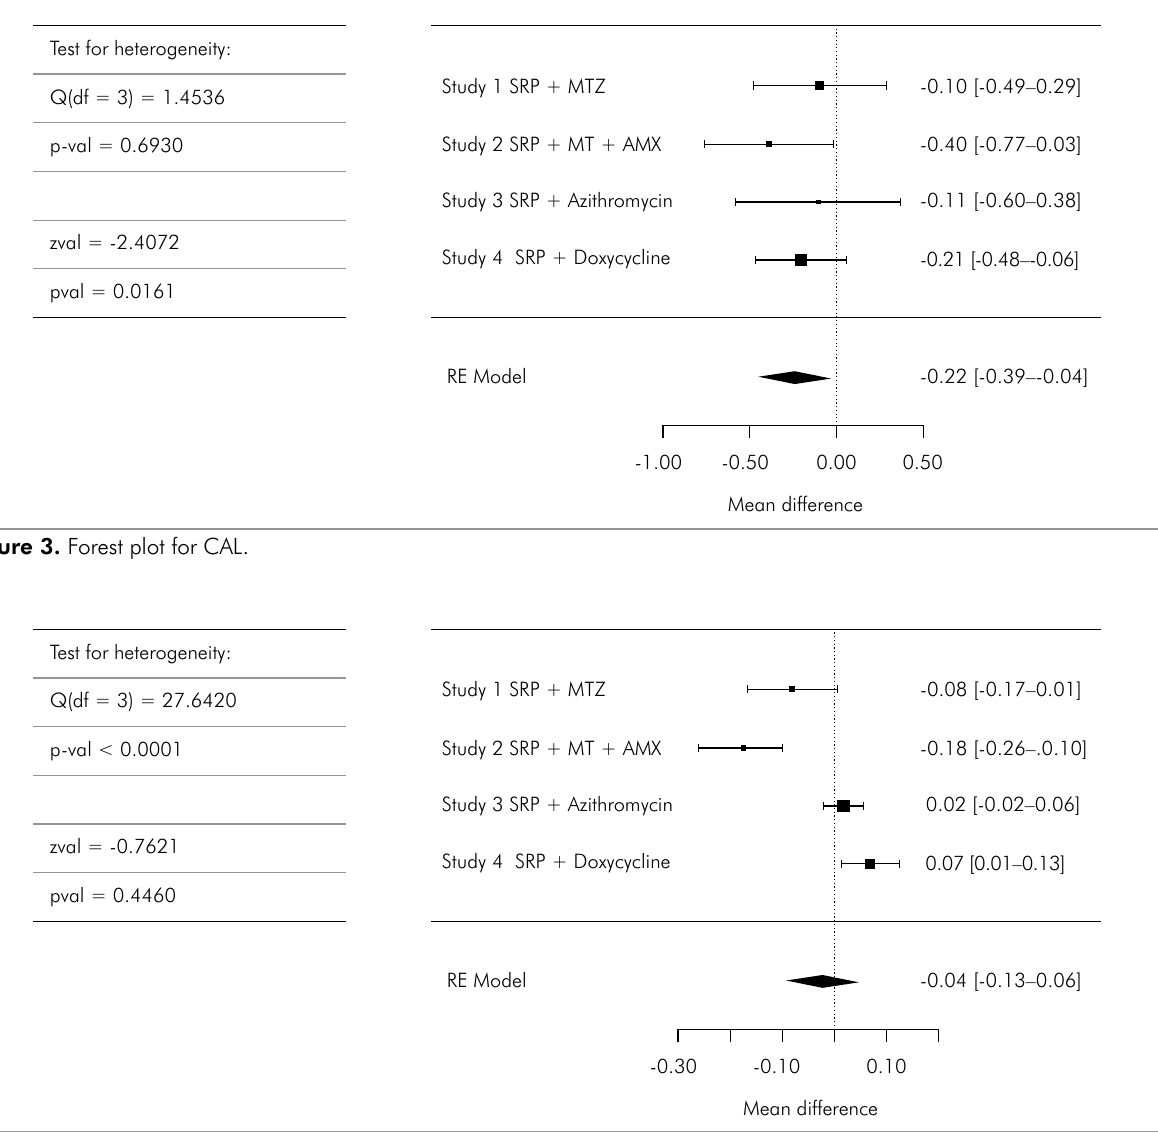
Figure 4. Forest plot for